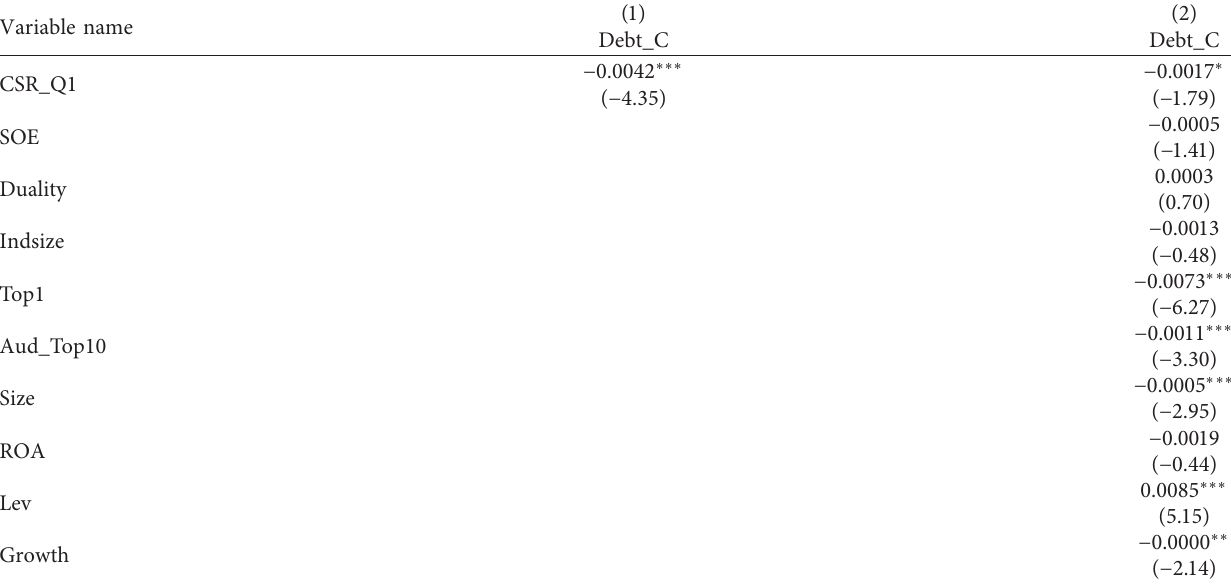
Table 9: Robustness test 2: replacement of social responsibility information disclosure quality